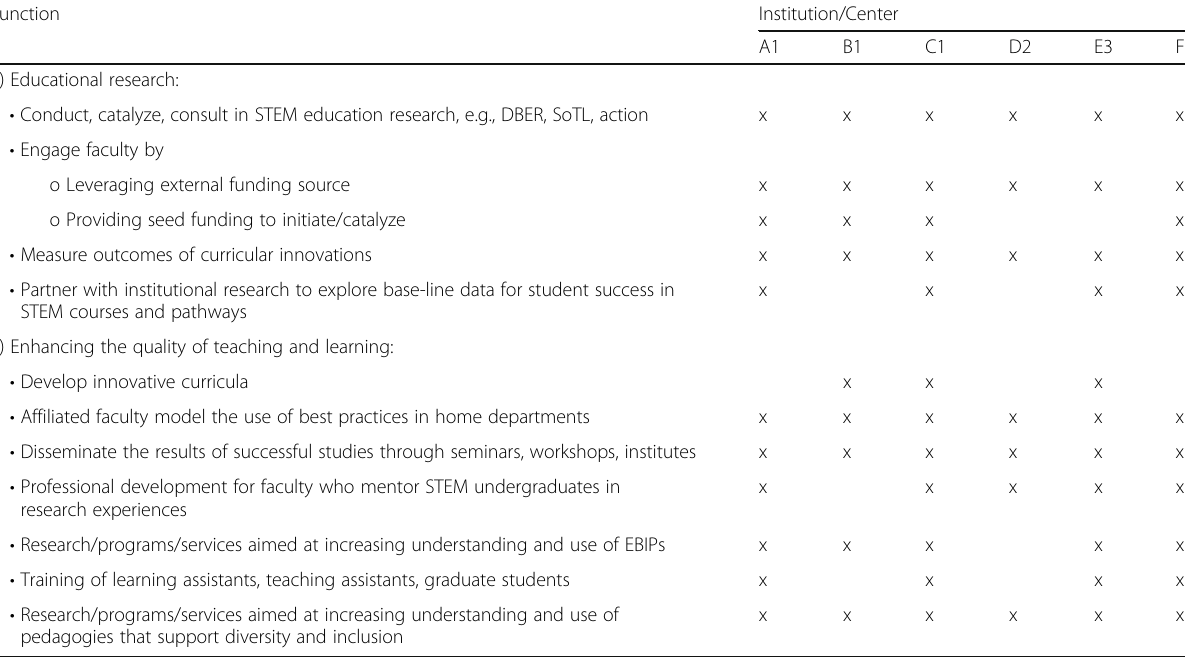
Table 4 SEC functions directed toward the improvement of STEM learning